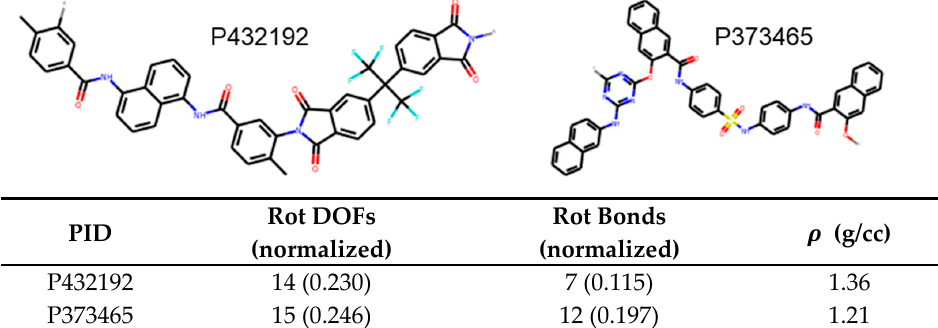
Figure 11 combines the results from this work to predict the trends of (cid:1846) (cid:3034) , (cid:1846) (cid:3040) , and (cid:2025)